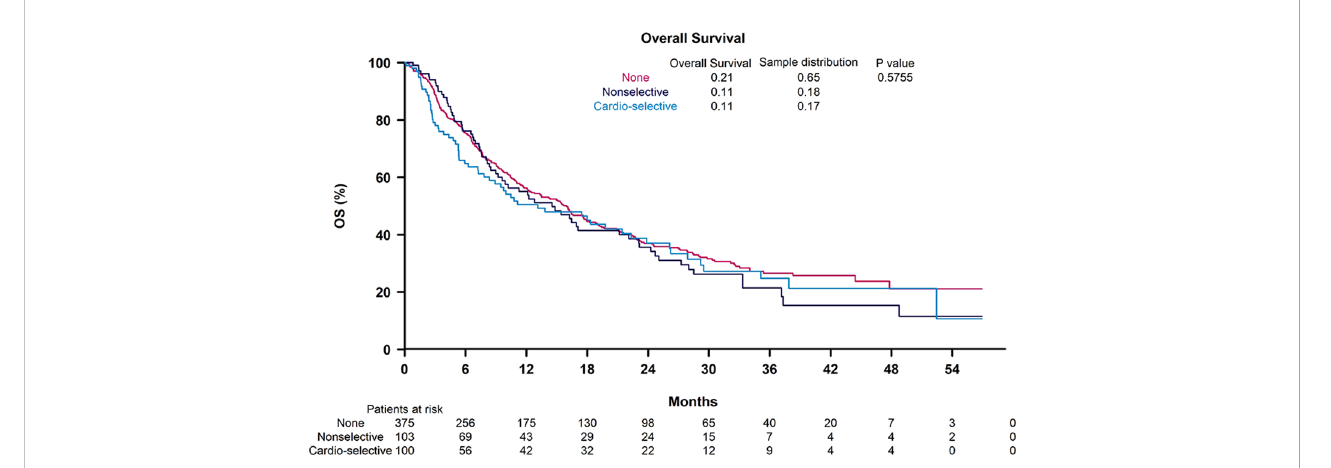
FIGURE 1 Kaplan-Meier curves for overall survival according to non-selective beta blocker (BB) use, cardioselective BB use, and no BB use.